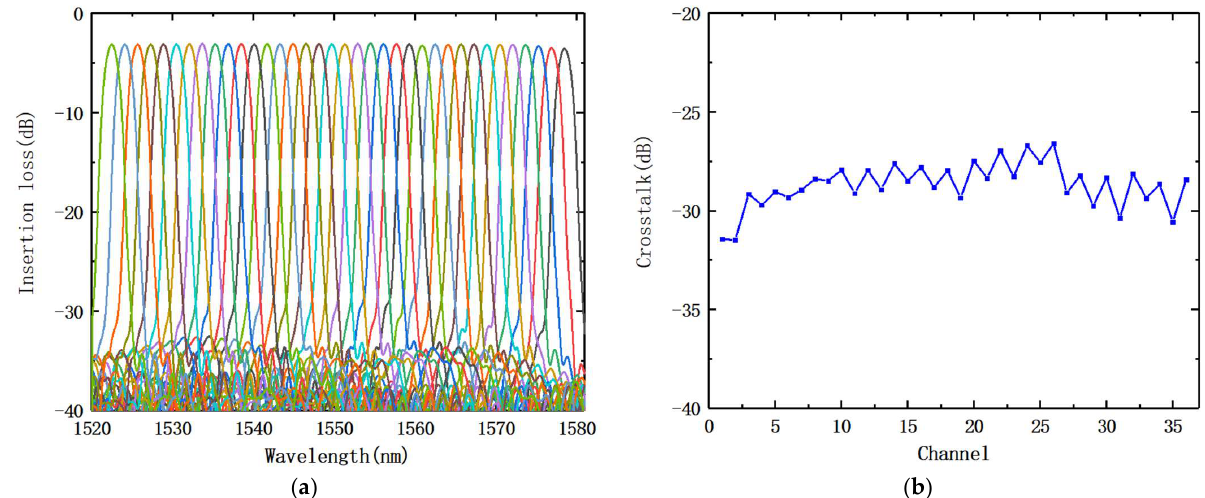
Figure 11. ( a ) Transmission spectra of AWG; ( b ) non-adjacent channel crosstalk of each AWG channel. Table 2. Detailed performance measurement of our AWG.